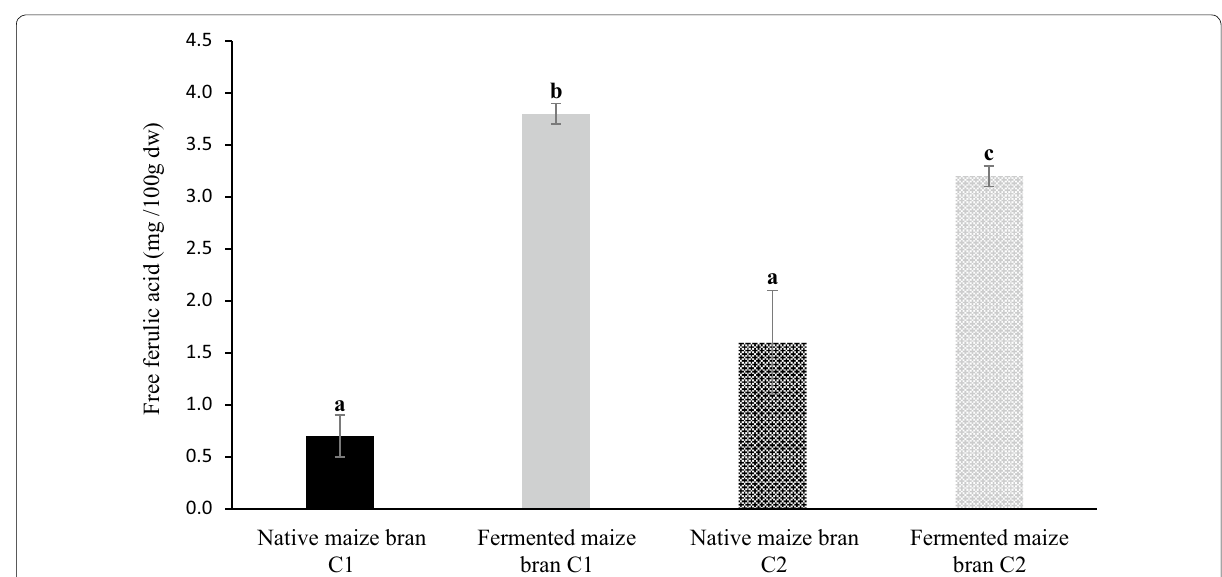
Data in the same row not sharing common letters are significantly different ( p < 0.05)